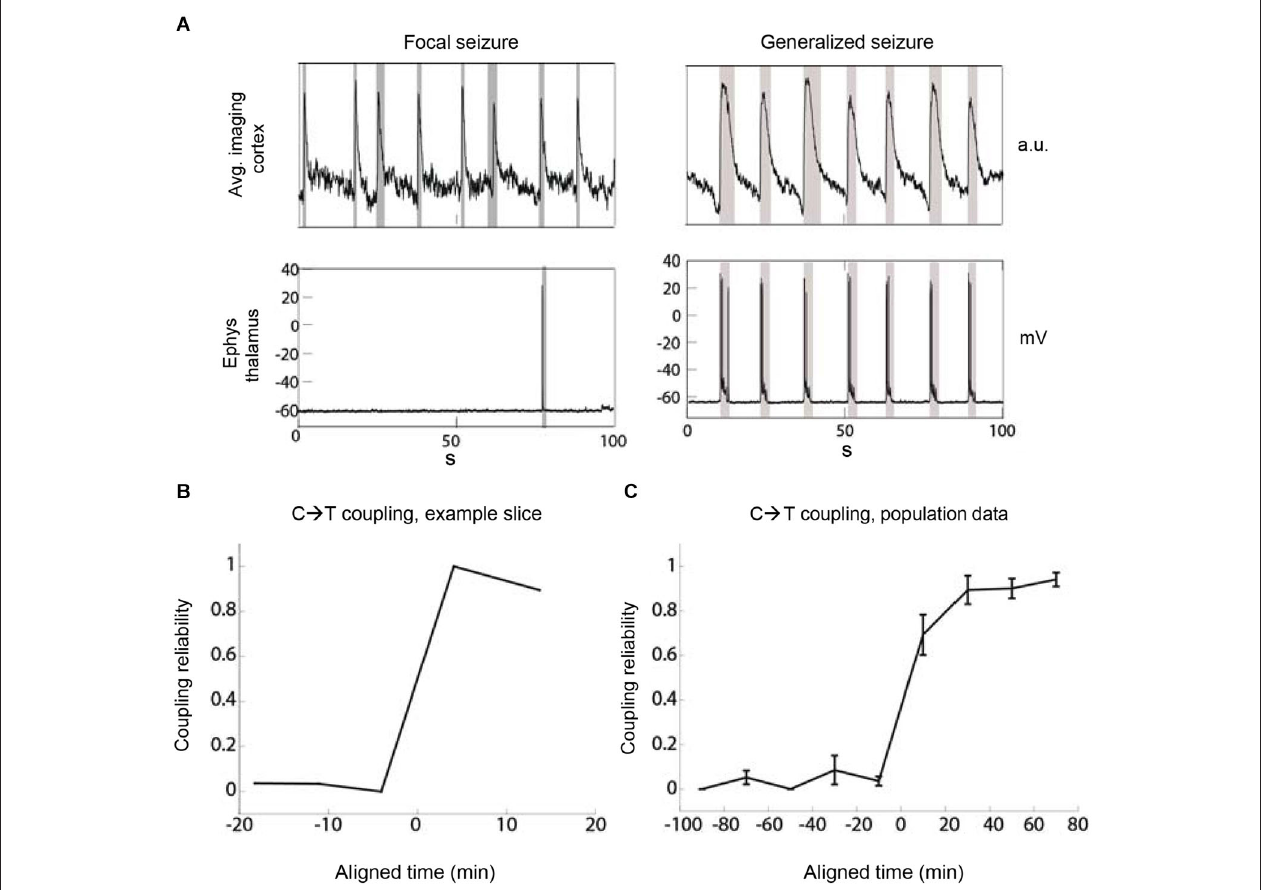
= 1, respectively. Gray boxes indicate detection boundaries of discharges. (B) The evolution of CR over time shows a sudden increase of corticothalamic coupling. Example TC slice. The time at which CR crosses 0.5 is aligned at 0. (C) Population data. The time at which CR crosses 0.5 was aligned at 0 before averaging. Bin size = 20 min, n = 6